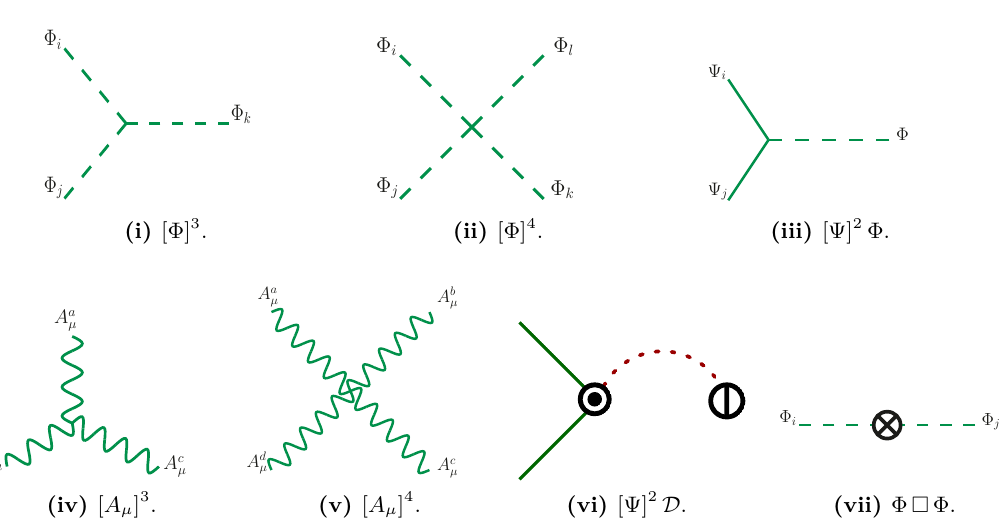
Figure 1 . Lorentz invariant vertices obtained from terms of the renormalizable Lagrangian.